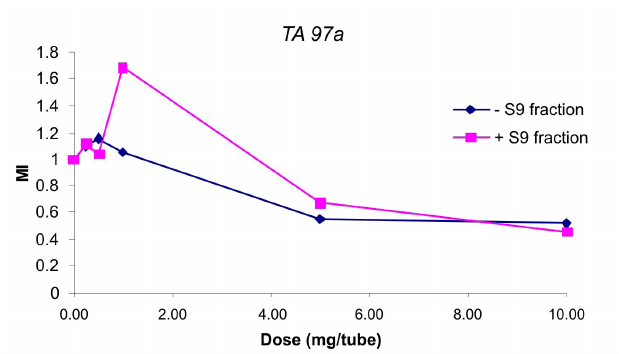
FIGURE 1 - Mutagenic Index (MI) as a function of dose (mg/tube) of “barbatimão” extract (BE), with or without S9 fraction on TA97a. The maximum coefficient of variation (CV) of experiments was 10%. Plots represent average of four independent